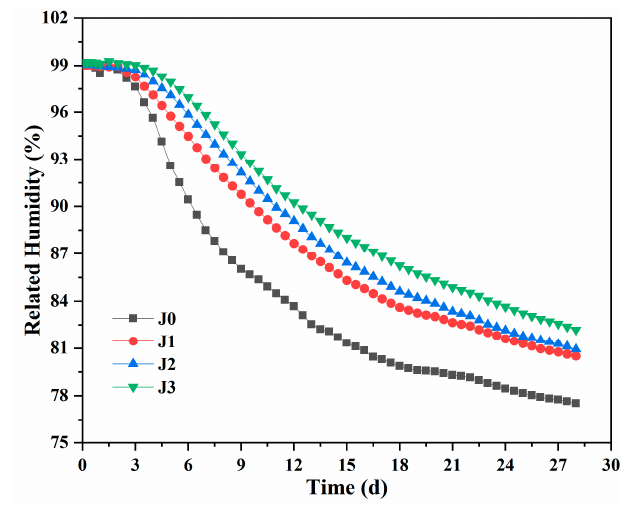
Figure 6. Internal relative humidity of M-S-H mortar with SRA.